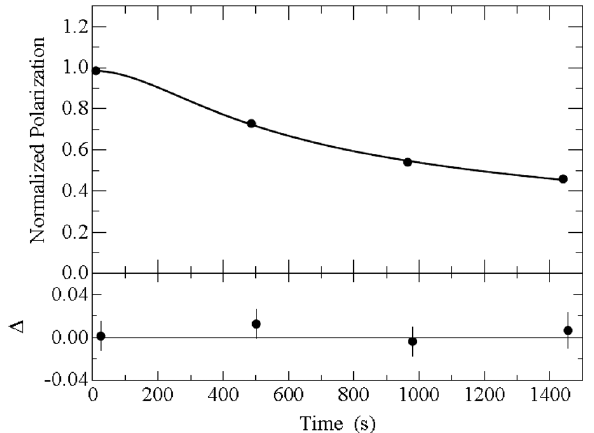
FIG. 11. (from Ref. [1]) Measurements of the normalized polarization. Least squares fits were made to the data acquired after rotation into the horizontal plane during four periods when the beam was extracted onto the polarimeter target. Data points taken with target extraction off are not shown. (The fitting template is based on an unfolded Gaussian beam distribution.) The residuals of the fit are given in the lower panel. The IPP lifetime is 782 (cid:2) 117